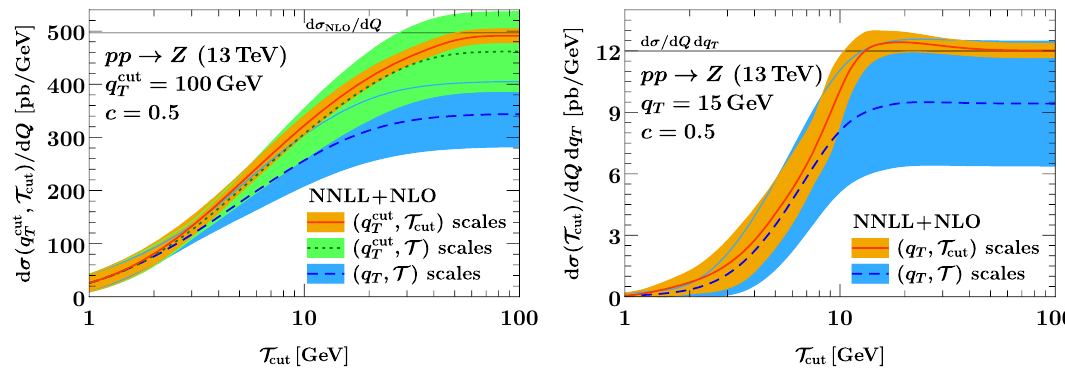
Figure 14 . Left: the double cumulant cross section as a function of T cut for q cut di(cid:11)erent scale setting prescriptions, with a modi(cid:12)ed slope c = 0 : 5 of the SCET I pro(cid:12)le scales, see eq. (3.32). Right: the q T spectrum with a cut on T as a function of T cut for di(cid:11)erent scale setting prescriptions, also using modi(cid:12)ed SCET I pro(cid:12)le scales with c = 0 : 5. The bands indicate the total perturbative uncertainty (cid:1) total , see section